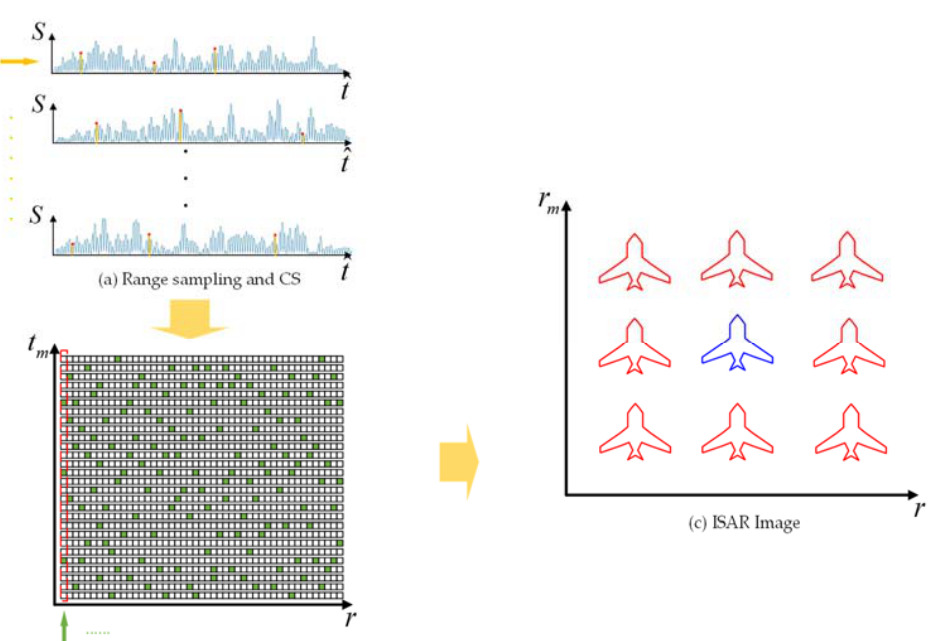
Figure 2. T he CS ‐ based anti ‐ jamming method against